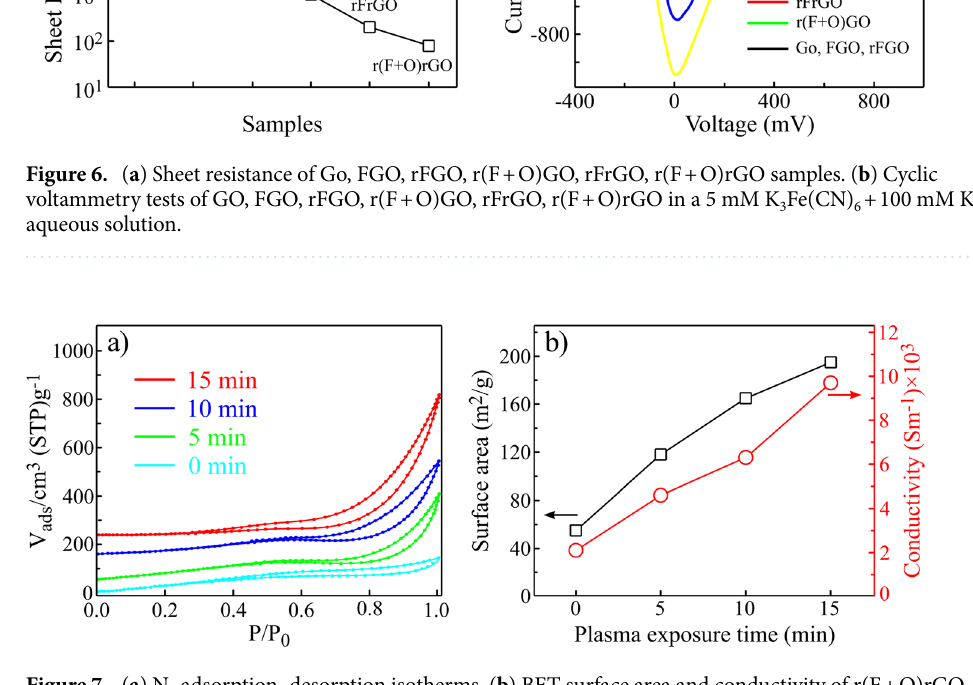
Figure 7. ( a ) N 2 adsorption–desorption isotherms, ( b ) BET surface area and conductivity of r(F + O)rGO samples with different SF 6 + O 2 plasma exposure